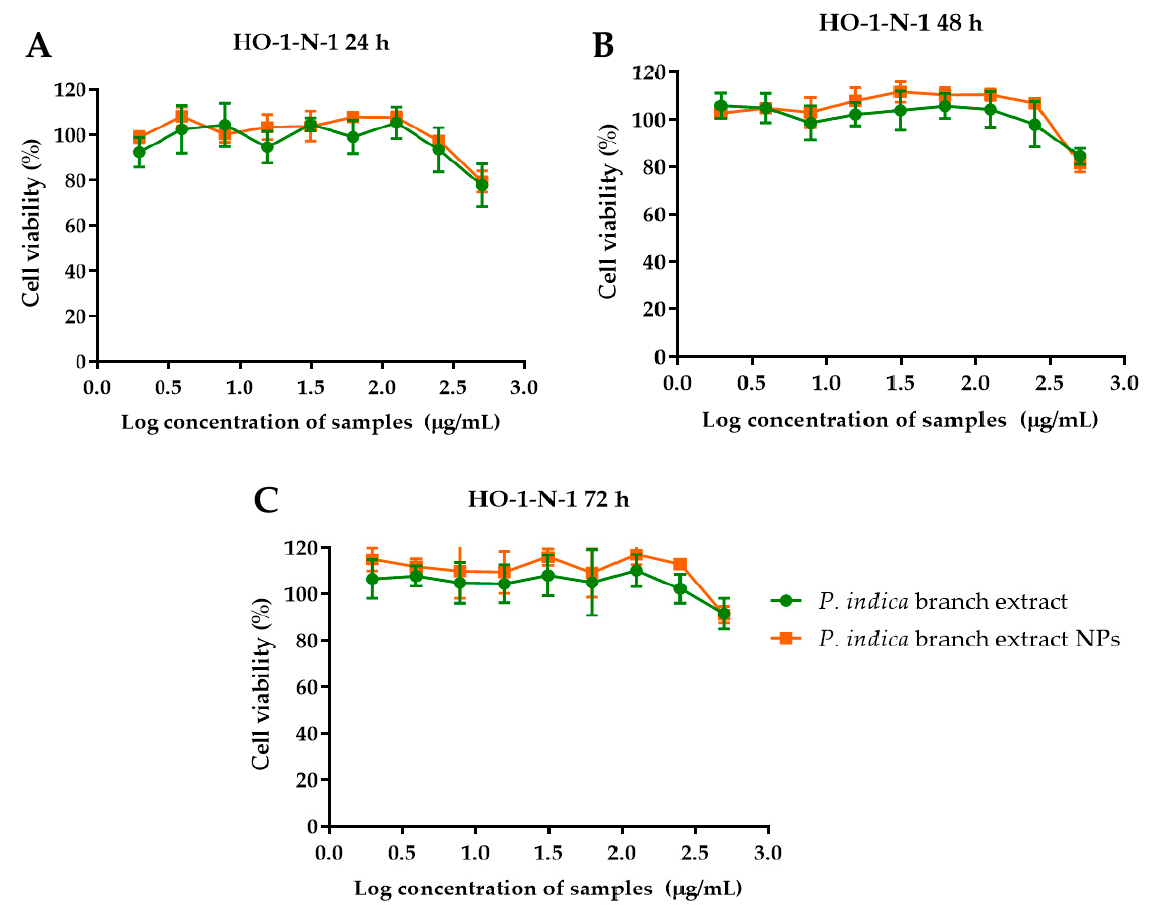
Figure 5. Effect of P. indica branch extract and NPs on human dermal fibroblast cell viability after incubation for ( A ) 24 ( B ) 48 and ( C ) 72 h. The data represent mean ± SD of three experiments.